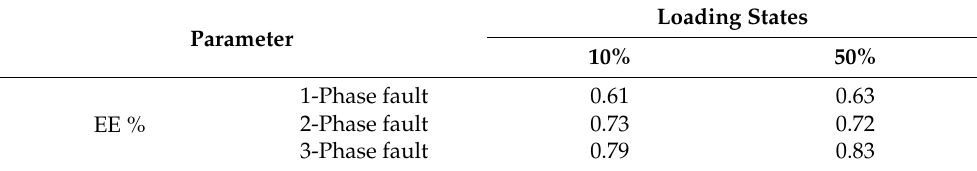
Table 3. Performance sensitivity analysis of the proposed algorithm for uncertainty in loading